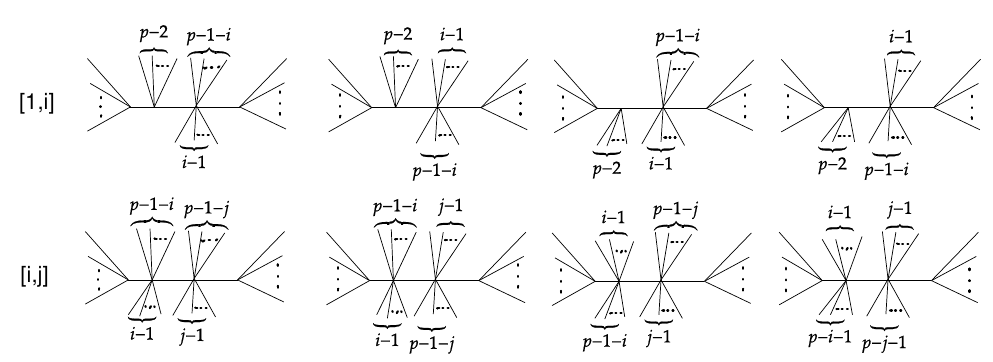
Figure 7 . The primitive graphs of the type [ i; i ].